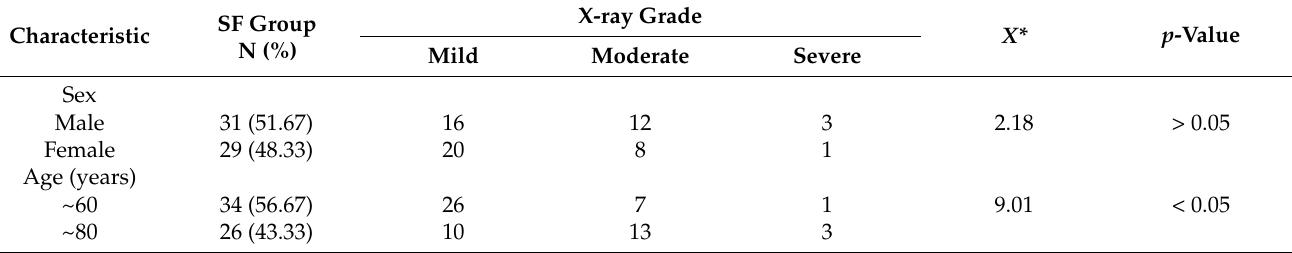
Table 2. X-ray grade analysis of SF patients ( n = 60) of different ages and